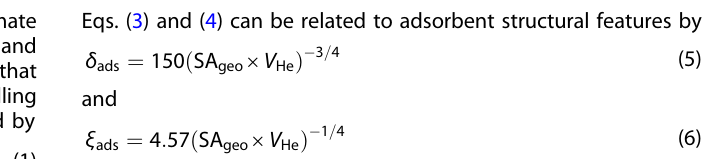
Fig. 3 Evaluation of adsorption-induced swelling. a Simulated swelling (V/V o ) as a function of adsorbate loading (Q) for PIM-1 with example adsorbate species: acetonitrile (black), dimethyl ether (blue), propionitrile (red), acetone (green), n-butane (orange), dimethyl sul fi de (gray), n- pentane (yellow), n-hexane (purple), dipropyl ether (cyan), n-heptane (navy). b Parity plot across all adsorbent – adsorbate pairs indicating the quality of fi tting simulated swelling data with the piecewise quadratic and linear relationships de fi ned in the text. Error bars indicate 95% con fi dence intervals (1.96 standard deviations) from simulations of independent replicas.